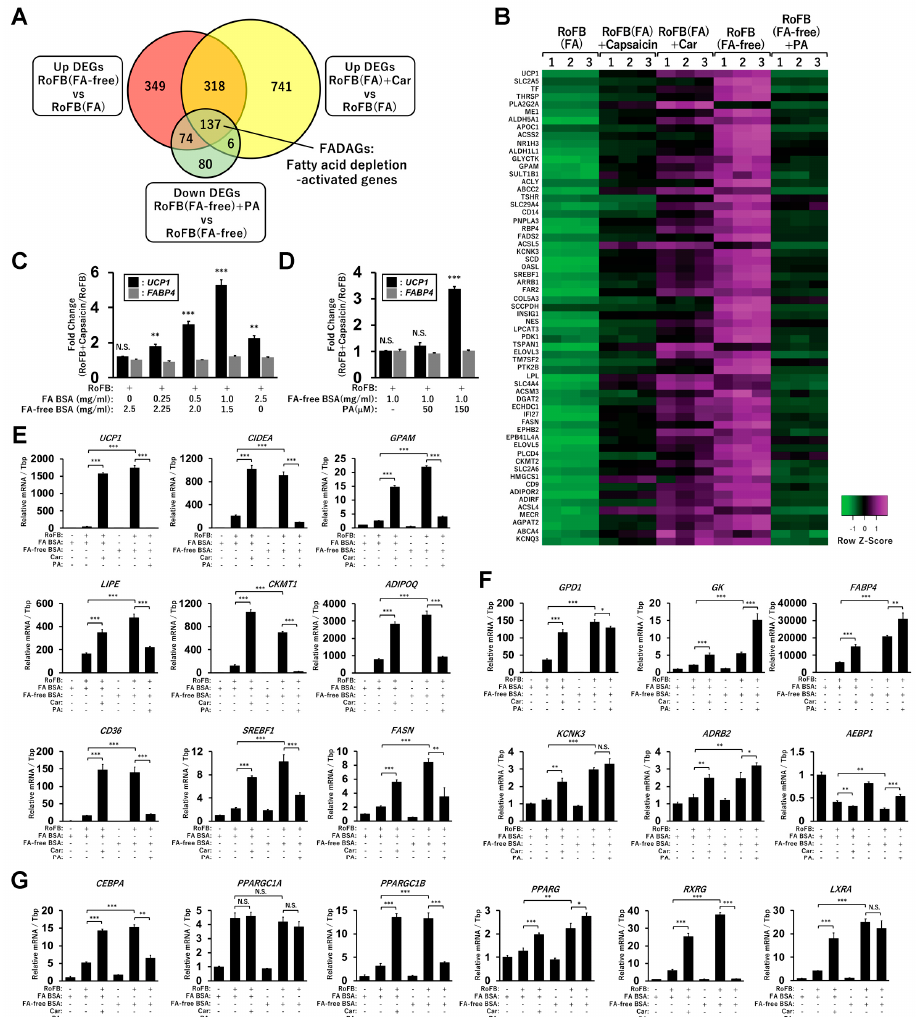
Figure 4. A set of lipid metabolic and synthetic genes are regulated with UCP1 in ciBAs. ( A ) Venn diagram represents the overlap of the upregulated DEGs in RoFB(FA-free) and RoFB(FA) + Car and the downregulated DEGs in RoFB(FA-free) + PA. The 137 overlapped DEGs are referred to as fatty acid depletion-activated genes (FADAGs). ( B ) Heat map shows transcriptional profiles of representative FADAGs in ciBAs converted under different conditions. ( C ) The fold change of UCP1 and FABP4 expression in the treatment with capsaicin was quantified in ciBAs treated with varying amounts of FA-binding BSA. ( D ) The fold change was quantified in ciBAs treated with FA-free BSA (1.0 mg/mL) and PA (50 and 150 µ M). ( E , F ) The expression of UCP1 , CIDEA , GPAM , LIPE , CKMT1 , ADIPOQ , CD36 , SREBF1 , and FASN ( E ) as well as GPD1 , GK , FABP4 , KCNK3 , ADBR2 , and AEBP1 ( F ) was quantified using qRT-PCR in ciBAs converted under different conditions. ( G ) The expression of transcription factors, such as CEBPA , PPARGC1A , PPARGC1B , PPARG , RXRG , and LXRA was quantified. Data represent mean ± SD ( n = 3). Student’s t -test: * p < 0.05, ** p < 0.01, *** p < 0.001, N.S.; not